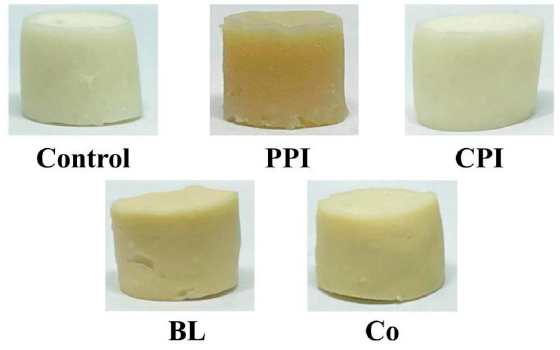
Figure 5. Appearance of soybean oil fish sausage pre-emulsified with different proteins. Table 5. Effect of soybean oil with different protein pre-emulsification on the colour of fish sausage. Sample